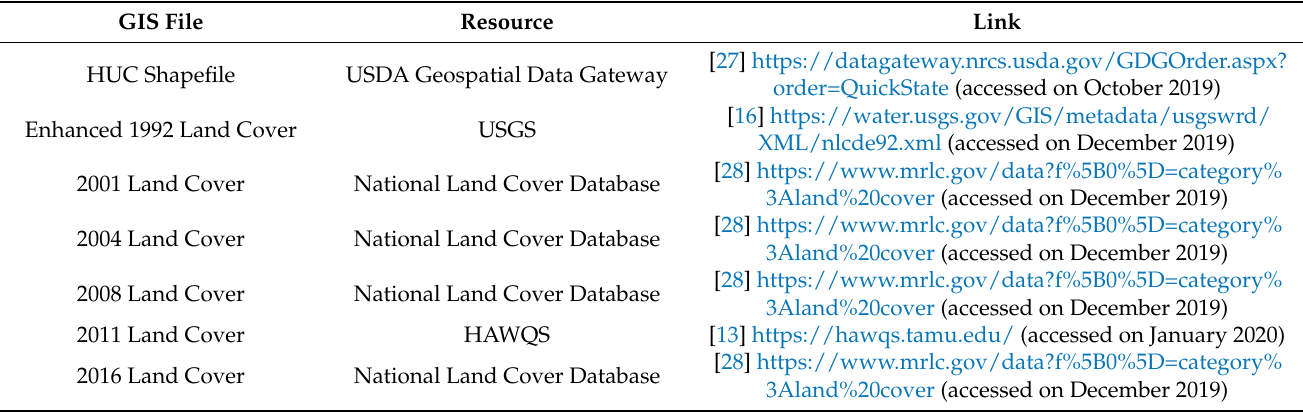
Table A6. GIS files and resources used for supplemental land cover